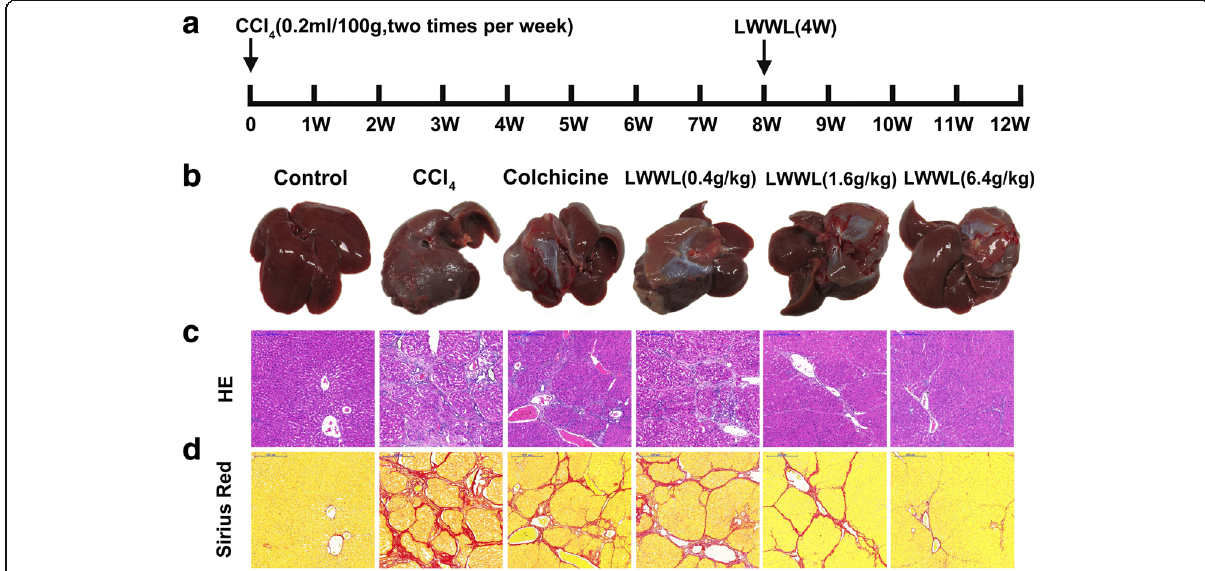
Fig. 1 LWWL inhibited CCl 4 -induced rat liver fibrosis. a Schematic representation of the CCl 4 -induced hepatic fibrosis in rats; b Representative rat livers at the time of sacrifice; c Representative rat livers stained with HE at the time of sacrifice; d Representative rat livers stained with Sirius Red (× 100) at the time of